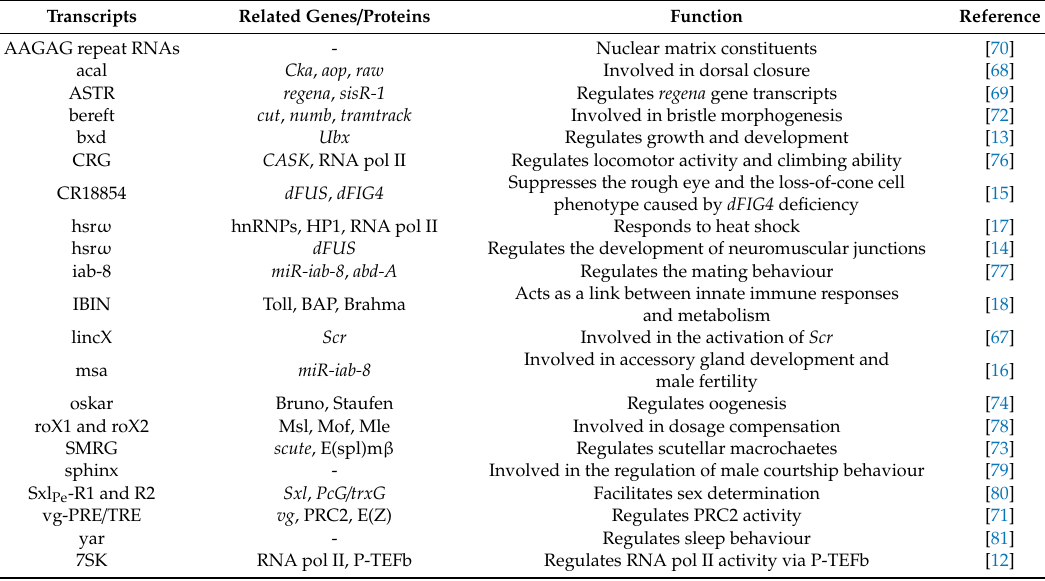
Table 1. LncRNAs in Drosophila